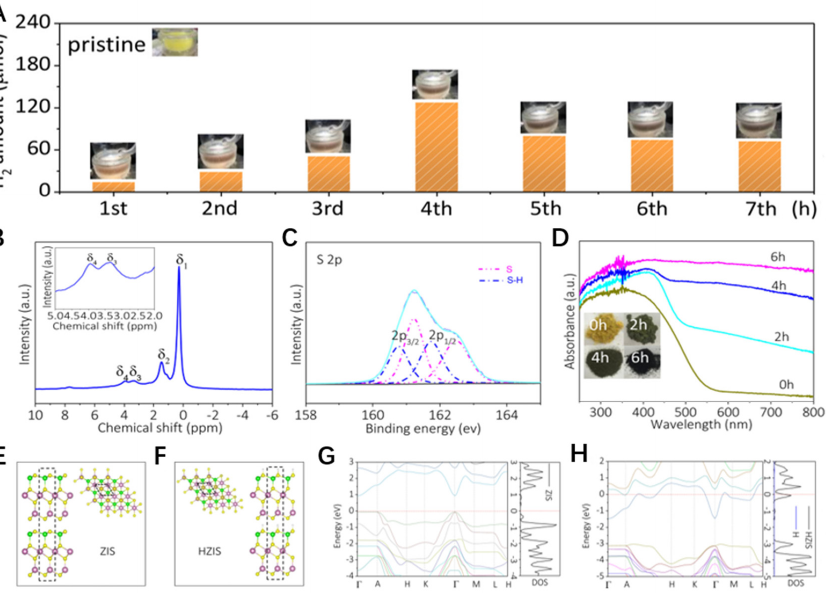
Figure 5. ( A ) Hydrogen content and corresponding color change of ZIS nanosheets at different time periods during the reaction. ( B ) H 1 solid-state NMR spectra of H x ZIS-6 h nanosheets. δ 3 and δ 4 are the signals of the S-H bonds; δ 1 and δ 2 are the signals of the adsorbed water molecules. ( C ) XPS spectrum of S 2p of H x ZIS-6 h. ( D ) UV–vis DRS spectra and photos of ZIS nanosheets at different time periods during the reaction. Top ( E ) and side ( F ) views of relaxed pristine ZIS systems and H x ZIS systems. ( G , H ) Electronic density of states of typical pristine ZIS systems and H x ZIS systems (DOS). Reproduced with permission [36], Copyright 2019, Elsevier.